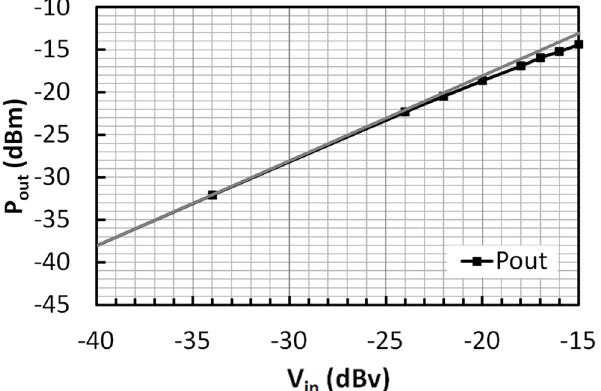
Figure 14. Measured 1-dB compression point of the LPF at 100 MHz.